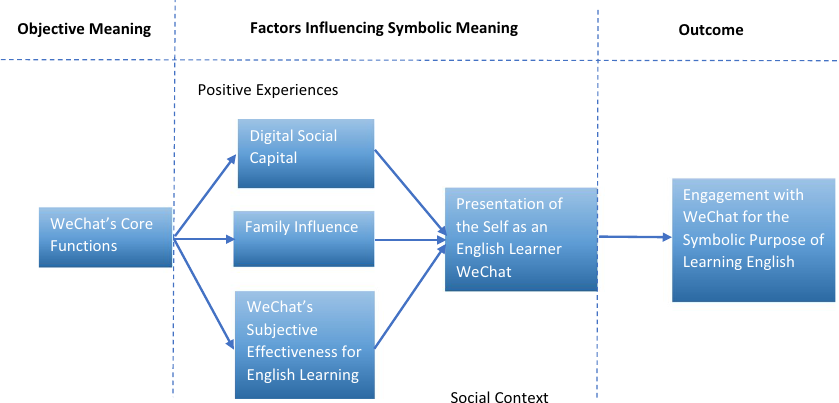
Fig. 1 Theoretical framework for examining WeChat as an EFL learning